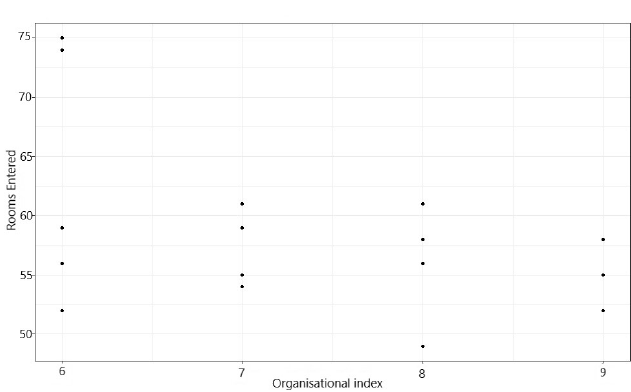
Figure 8. Rooms entered vs. Org index for 12-room simulations.